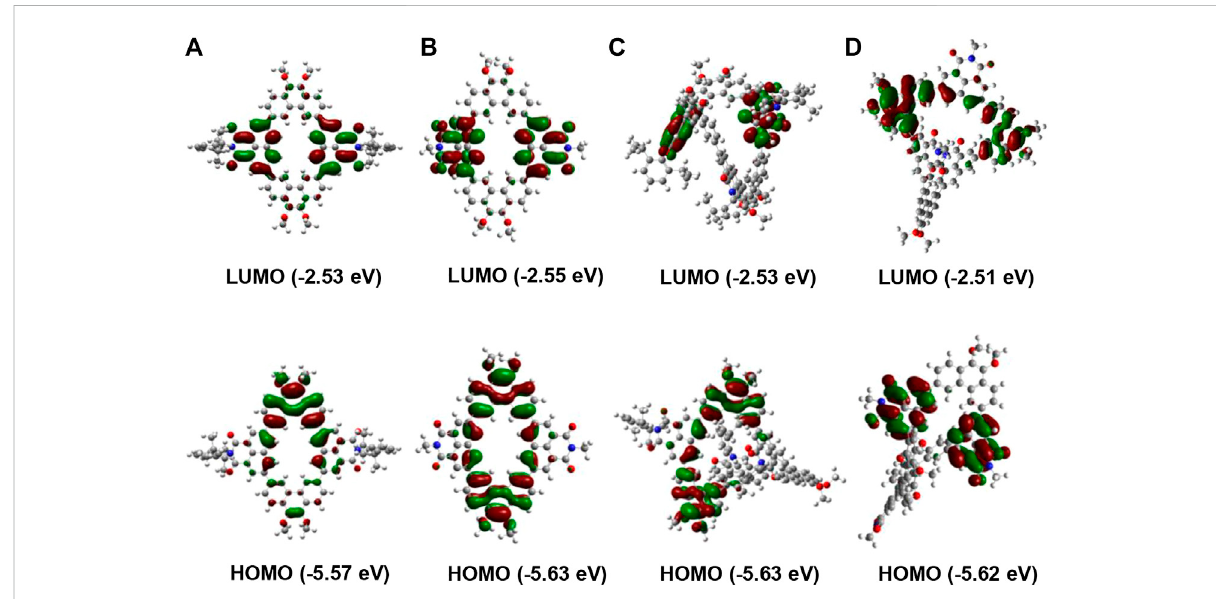
FIGURE 3 Frontier molecular orbital pro fi les and energy levels of the macrocycles calculated by DFT. (A) NP2a, (B) NP2b (C) NP3a, (D) NP3b.